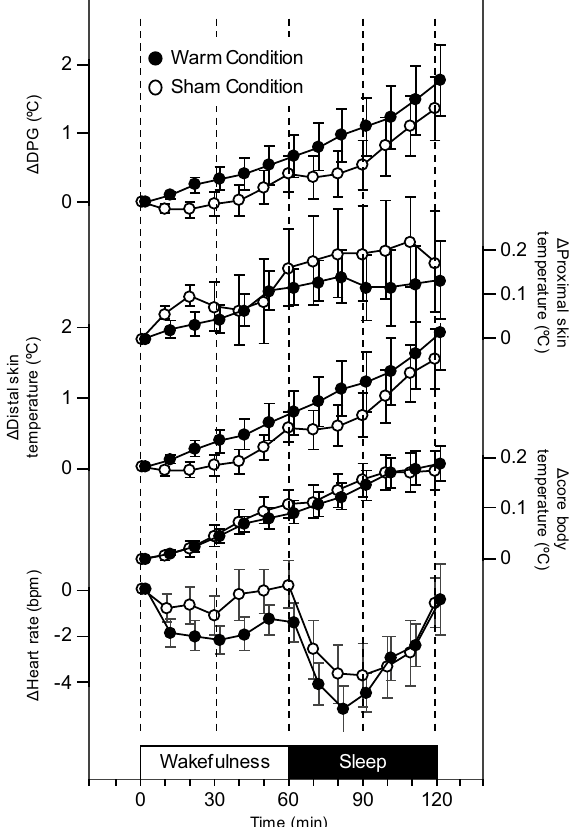
Figure 1. Time course (10 min means) of distal–proximal skin temperature gradient (DPG), proximal skin (infraclavicular) temperature, distal skin (foot) temperature, core body (rectum) temperature, and heart rate during the thermal manipulation period, observation period, and sleep period under the warming condition (closed circle) and sham condition (open circle). All values are presented as mean ± SEM of eighteen